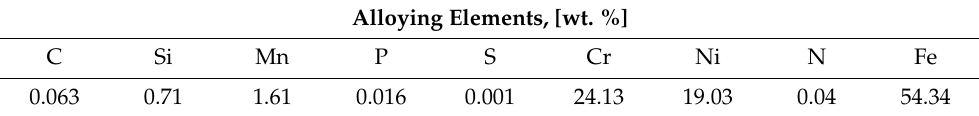
Table 1. Chemical composition of 310 H SS (provided by the supplier) [27]. Alloying Elements, [wt.